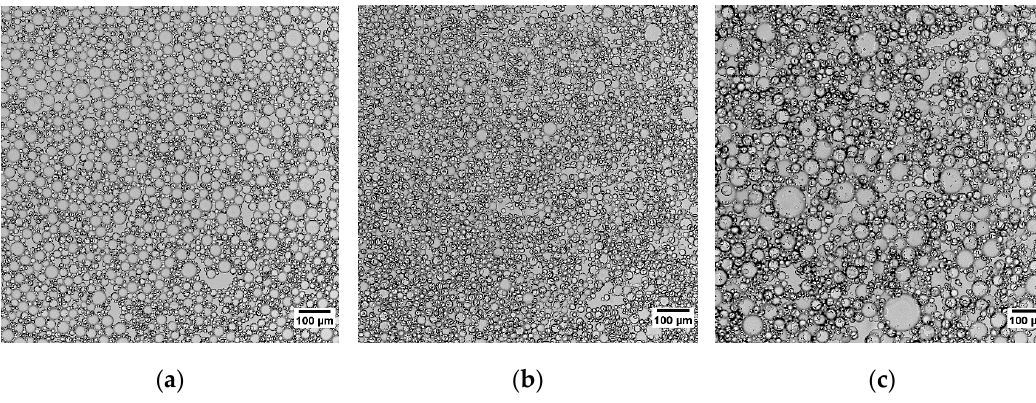
Figure 5. Images of silicone oil-alginate emulsions made with ( a ) 10 cSt silicone oil agitated with magnetic stirrer, ( b ) 10 cSt silicone oil agitated with mechanical stirrer, and ( c ) 500 cSt silicone oil agitated with magnetic stirrer. Table 1. Description statistics for the droplet size distributions of three different emulsion preparations, n = 350 for